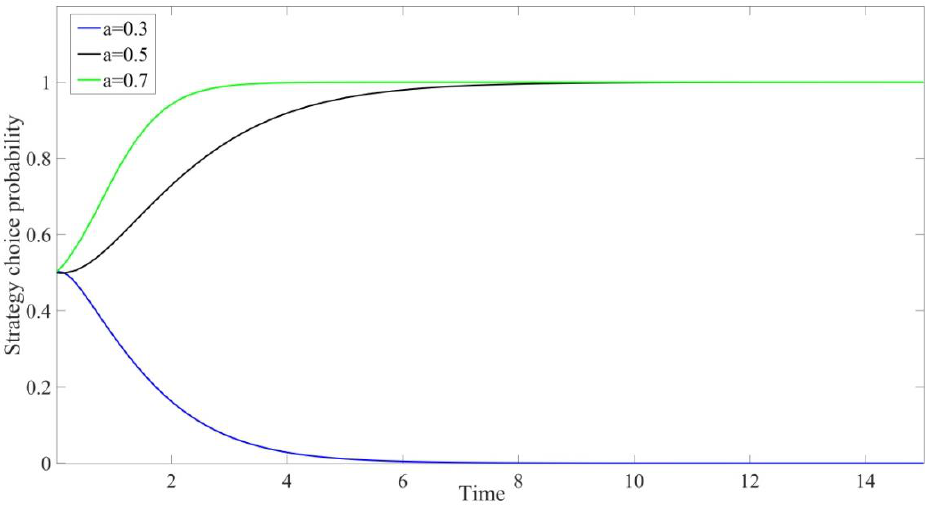
Figure 10. Simulation of different subsidy intensities.